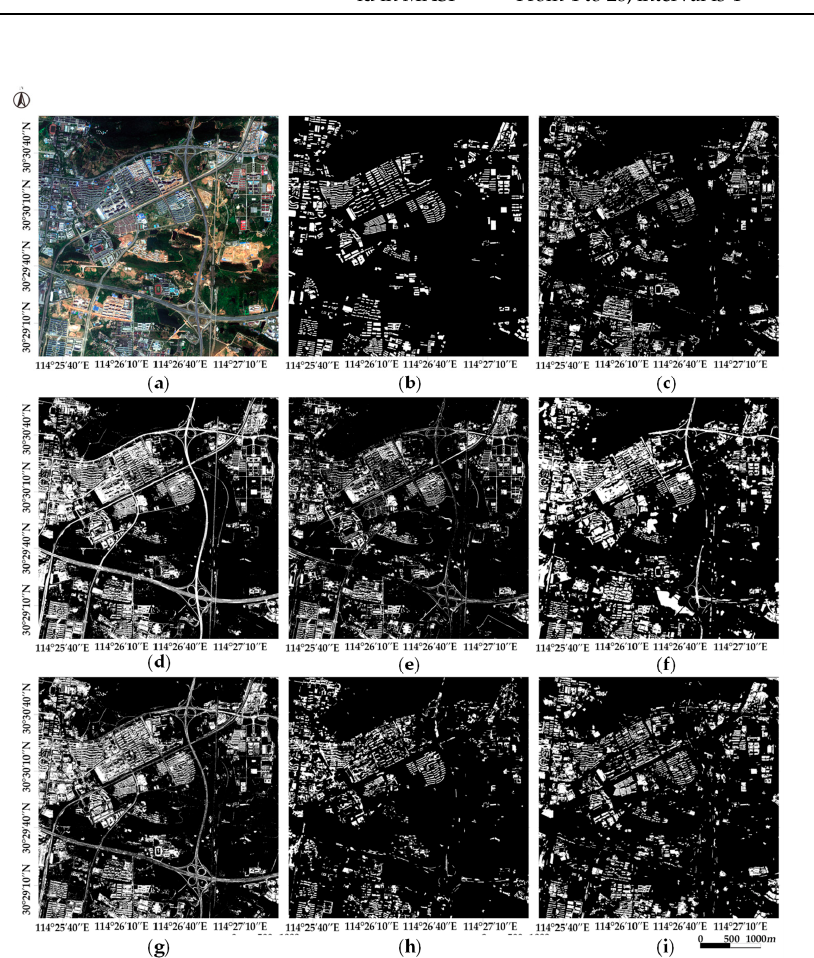
Figure 6. Building feature extraction results for Dataset 1: ( a , b ) the RGB image and the ground truth map; ( c ) the building detection resultof the MBI; ( d – f ) the building maps with the results of the pixel-based SVM, DMP-SVM, and object-oriented SVM, respectively; ( g , h ) the building detection results of DMP-RF and object-oriented RF; ( i ) the results of the proposed